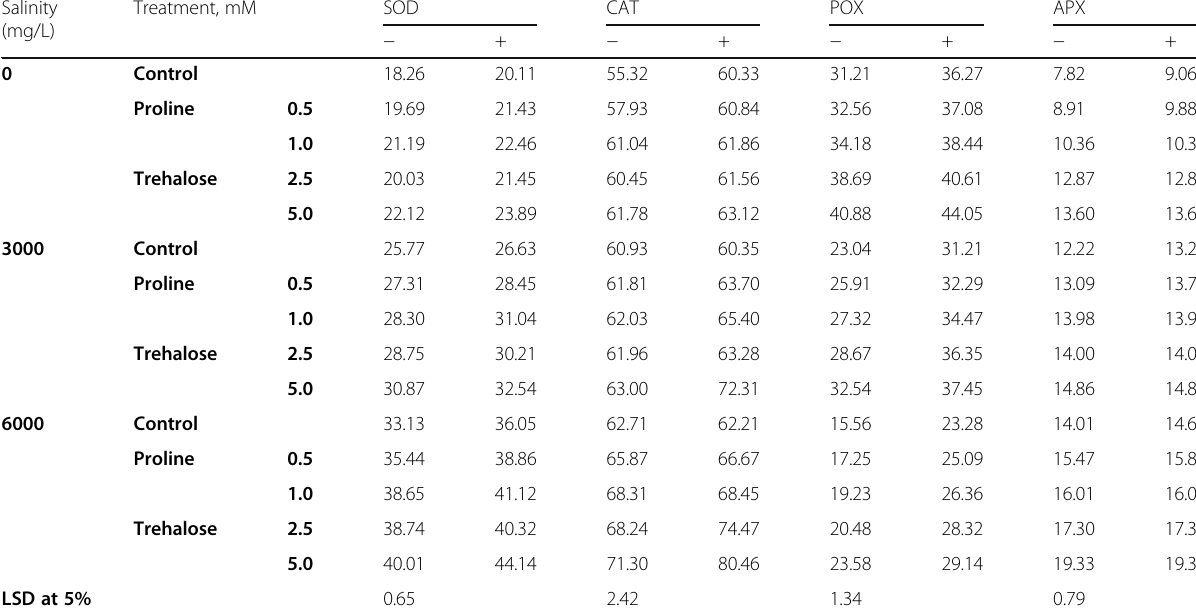
Table 6 Antioxidant enzyme ( μ g/g fw) of quinoa plants treated with proline or trehalose with (+) and without ( − ) compost amendment under salinity stress (average of two seasons) Salinity Treatment, (mg/L)